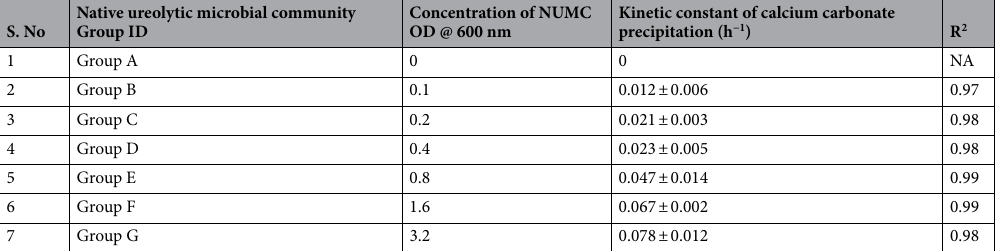
Table 1. The kinetic constant values of CaCO 3 precipitation at varying native ureolytic microbial community concentration. NUMC Native Ureolytic Microbial Community, NA not applicable. ± indicates the standard deviation of two independent